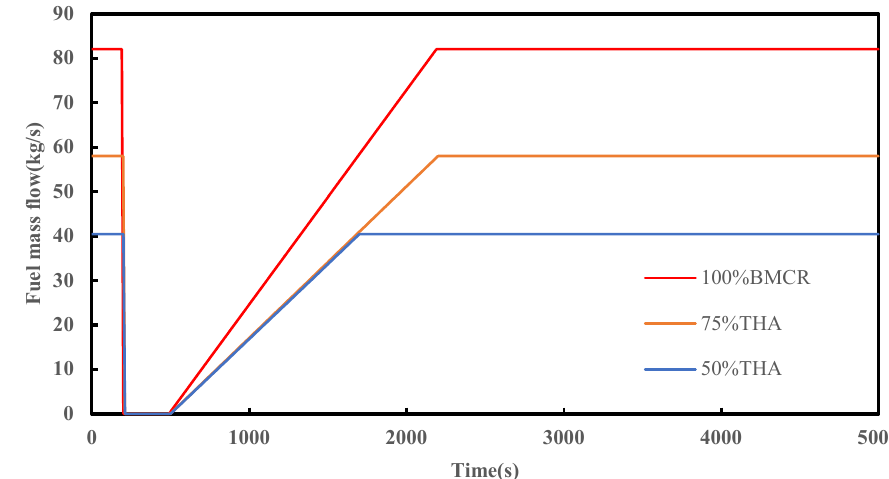
Figure 15. Response of fuel mass flow during MFT at different conditions.